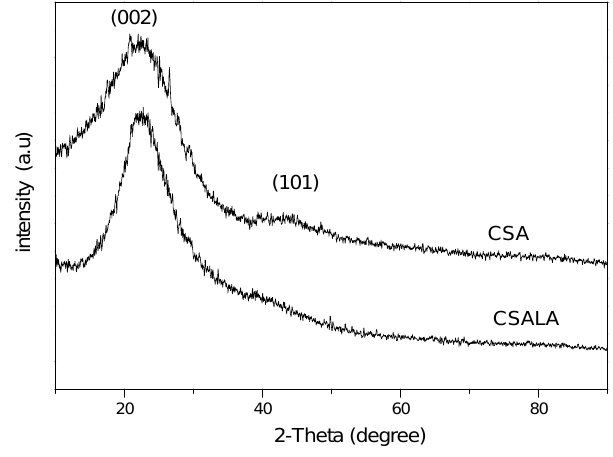
Figure 2. X ‐ ray powder diffraction (XRD) patterns of CSA and CSALA.